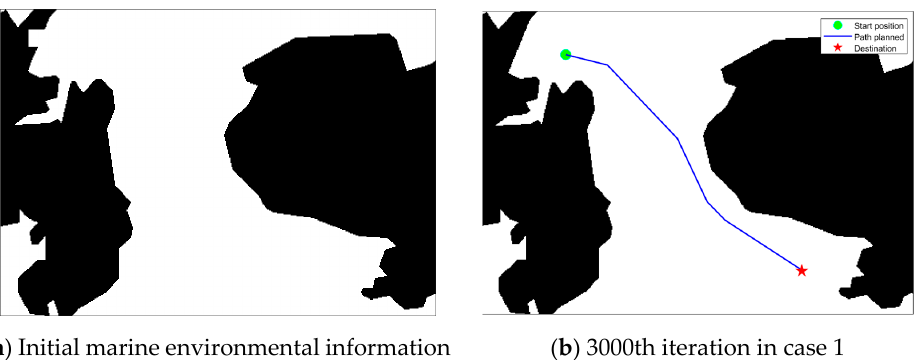
Figure 9. Path planning results in case 1 of marine environment. ( a ) Initial marine environmental information; ( b ) 3000th iteration in case 1.